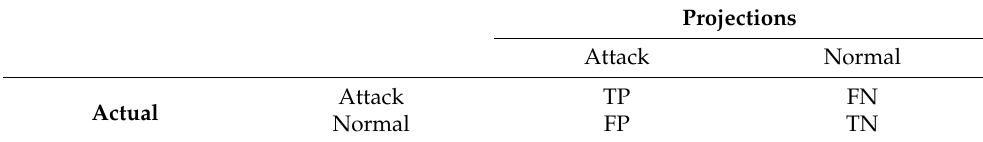
Table 3. Confusion matrix.